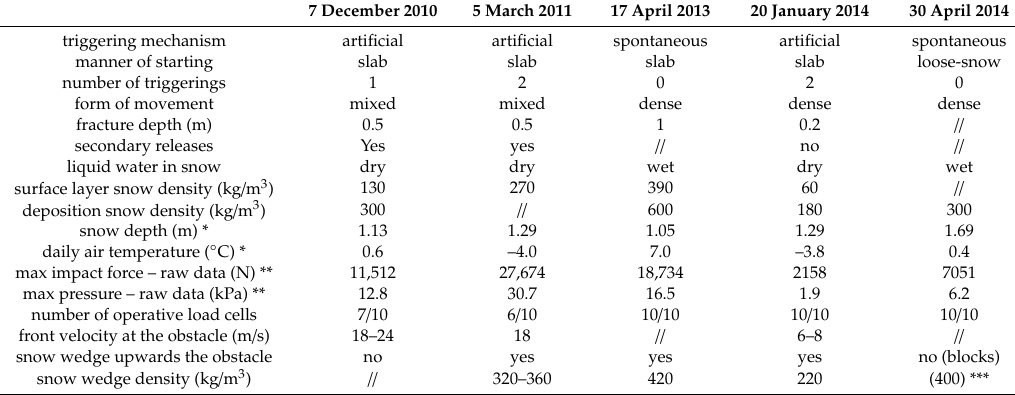
Table 1. Characteristics of the five selected avalanche events. Nomenclature as used in